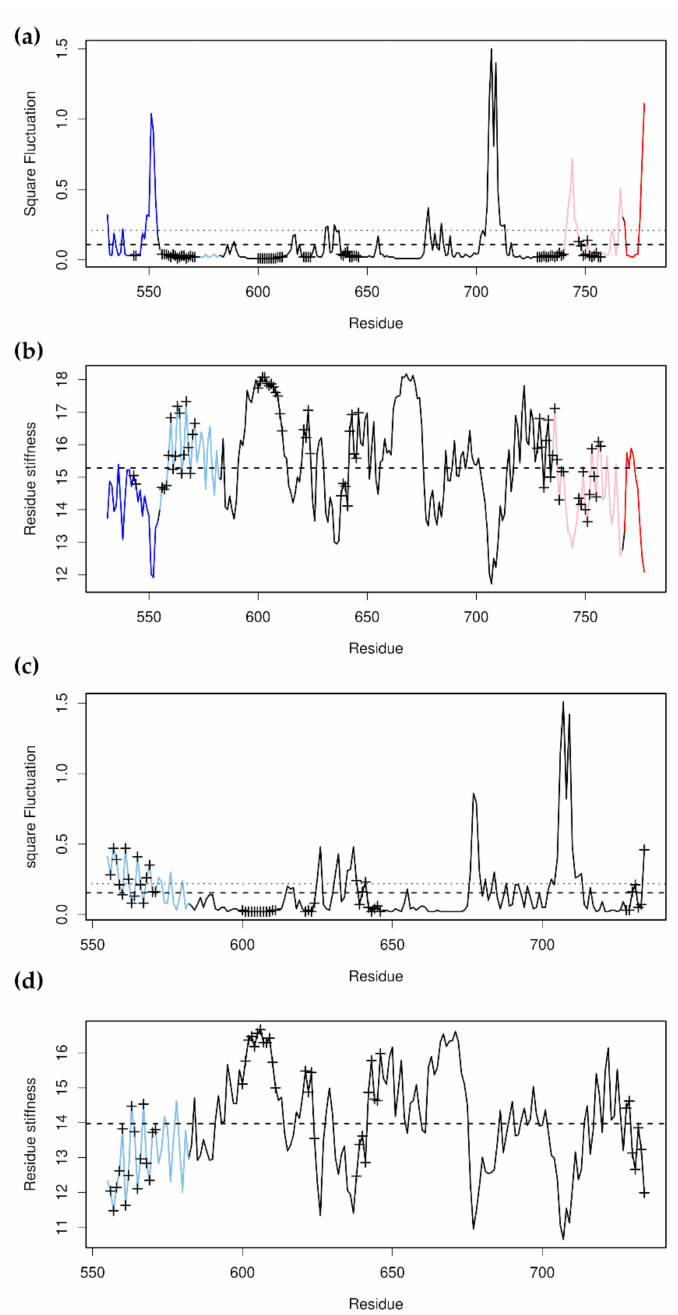
Figure 8. The overall square fluctuations and residue stiffness of the whole GCR-LBD (Figure 7a) and the second GCR-LBD truncation (Figure 7c). ( a , b ) show the square fluctuations and residue stiffness of the whole GCR-LBD, respectively, while ( c , d ) show the square fluctuations and residue stiffness, respectively, of the second GCR-LBD truncation. The plot is colored as in Figure 7. The crosses mark the residues that were within 8 Å of the ligand in PDB structure 1M2Z, and which were presumably part of the ligand-binding site. It can be seen that, discounting individual loops, NT1 and both CT1 and 2 had the greatest overall degree of flexibility and that the removal of NT1 and CT1 and CT2 greatly increased the flexibility of NT2. The consequences of this can be seen in Figure 9a